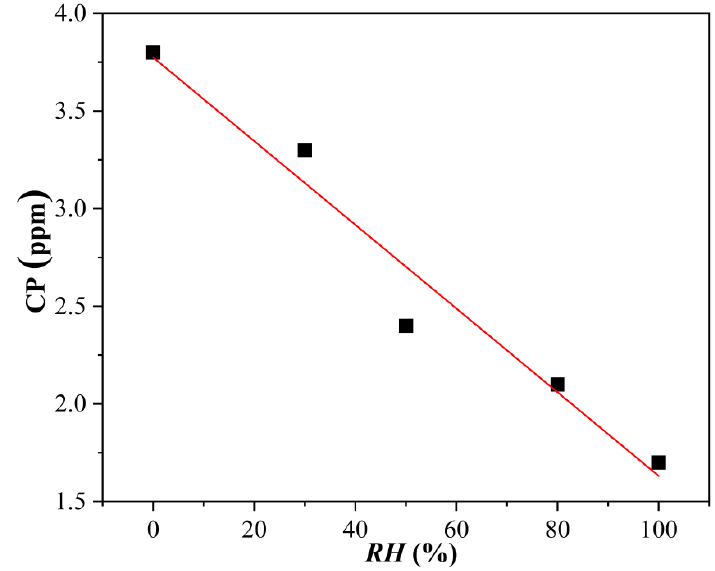
Figure 2. The influence of RH on CP of copper corrosion in H 2 S-containing